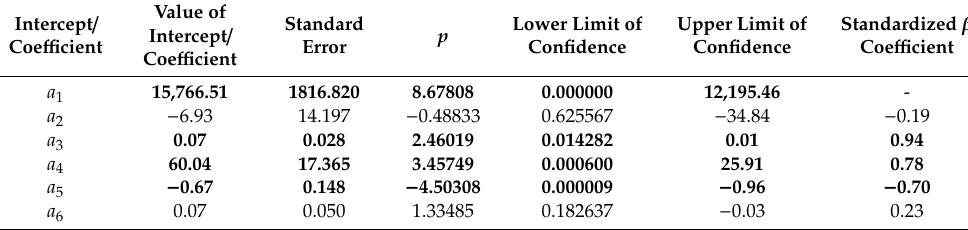
Table A1. Statistic evaluation of 3D model parameters of HHV (model 1).